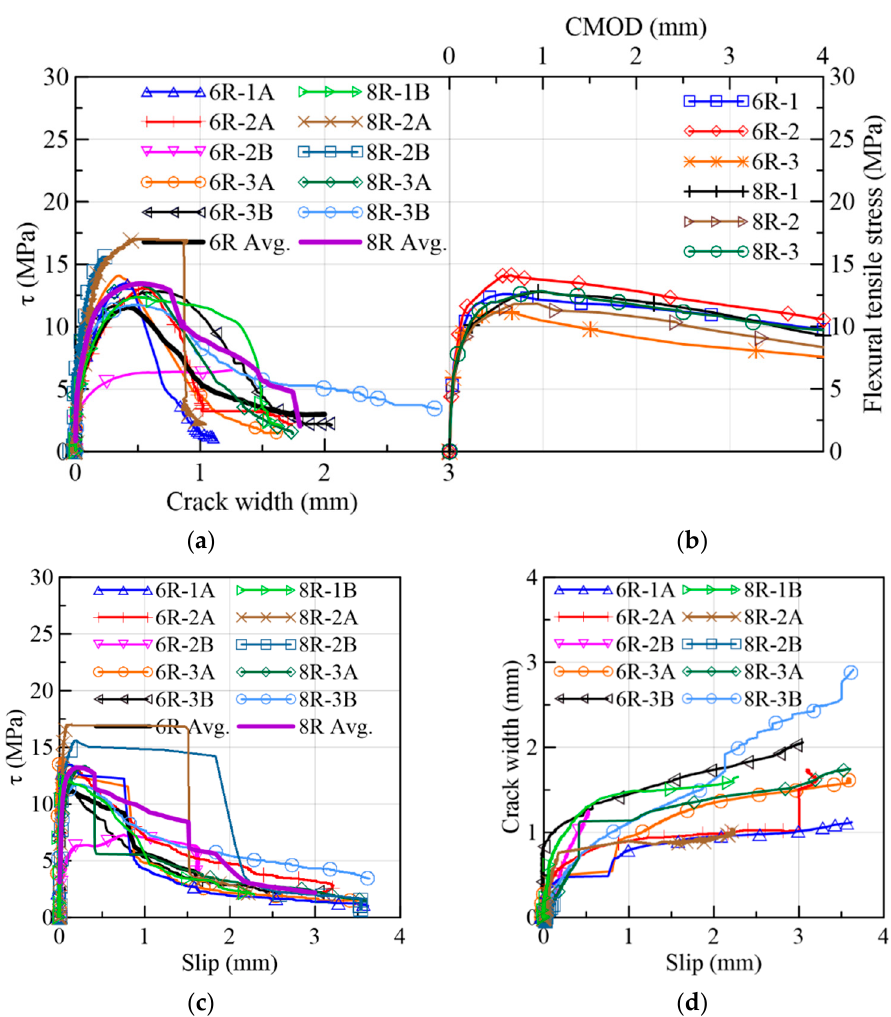
Figure 15. Mechanical results of 6R and 8R specimens: ( a ) shear stress vs. crack width; ( b ) flexural tensile stress vs. CMOD; ( c ) shear stress vs. slip; ( d ) crack width vs. slip.